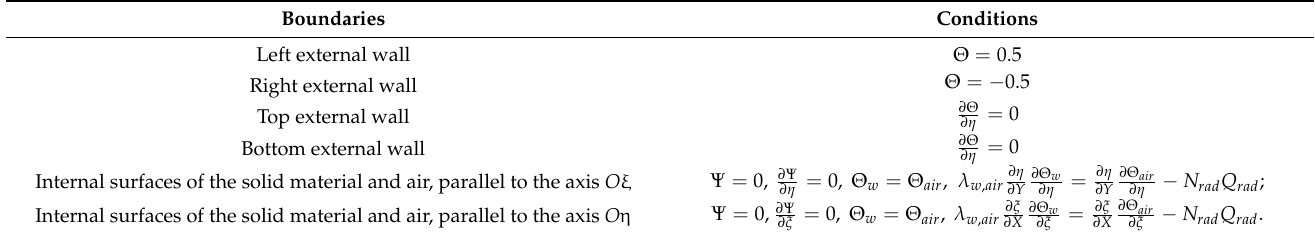
Table 2. Boundary conditions associated with Equations